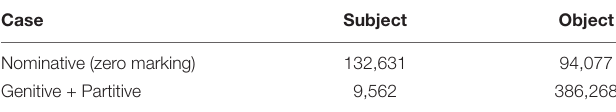
TABLE 4 | Frequencies of case forms in Finnish